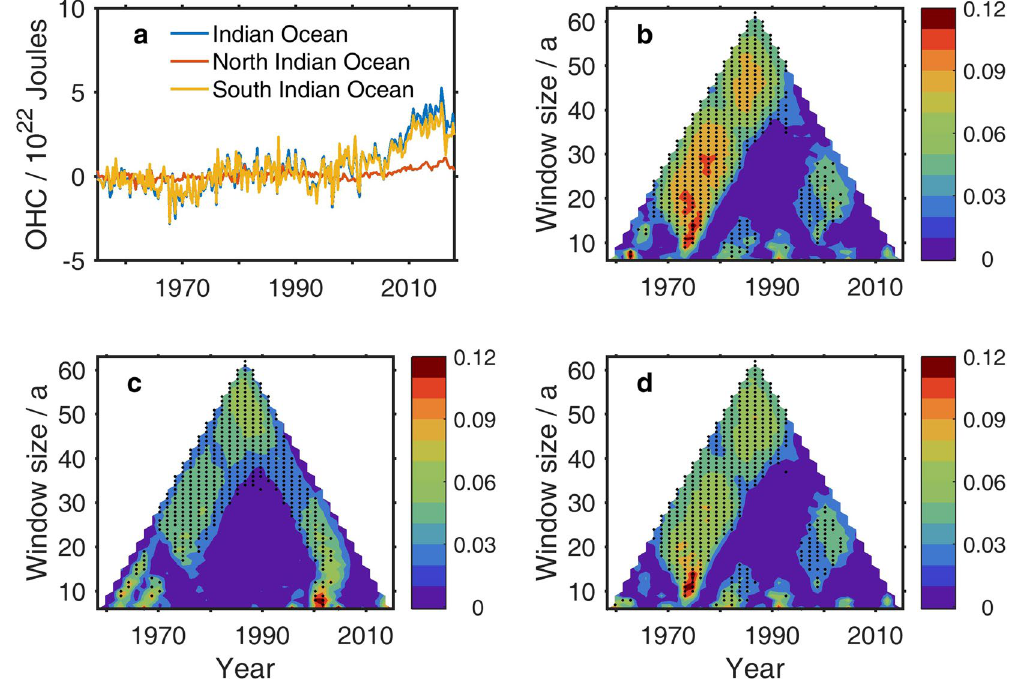
Figure 5. The original incorrect version of Figure